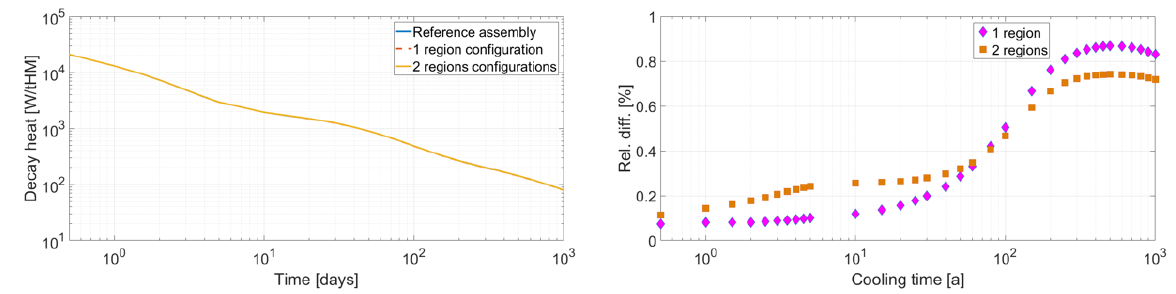
Figure 11. Decay heat rate as a function of cooling time for different assembly configurations with respect to the